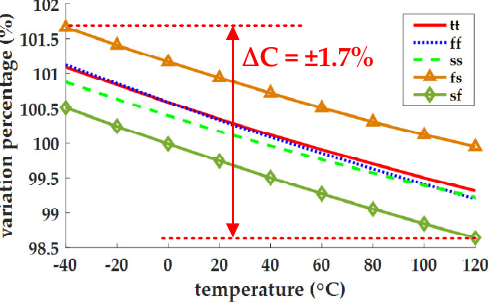
Figure 16. The simulated process and temperature variation of the total parasitic capacitance.